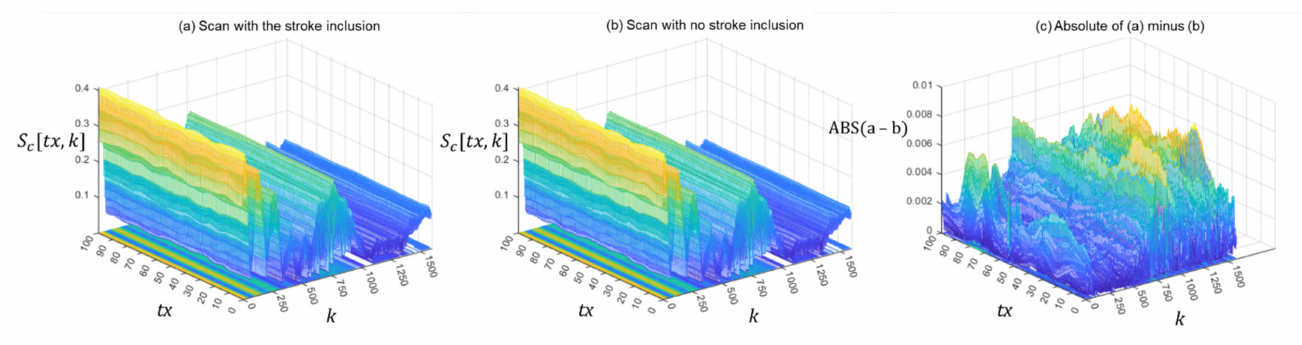
Figure 5. Magnitude of the raw data acquired during scan #1: ( a ) with the stroke inclusion, ( b ) without the inclusion, and ( c ) the absolute (ABS) of the difference between ( a , b